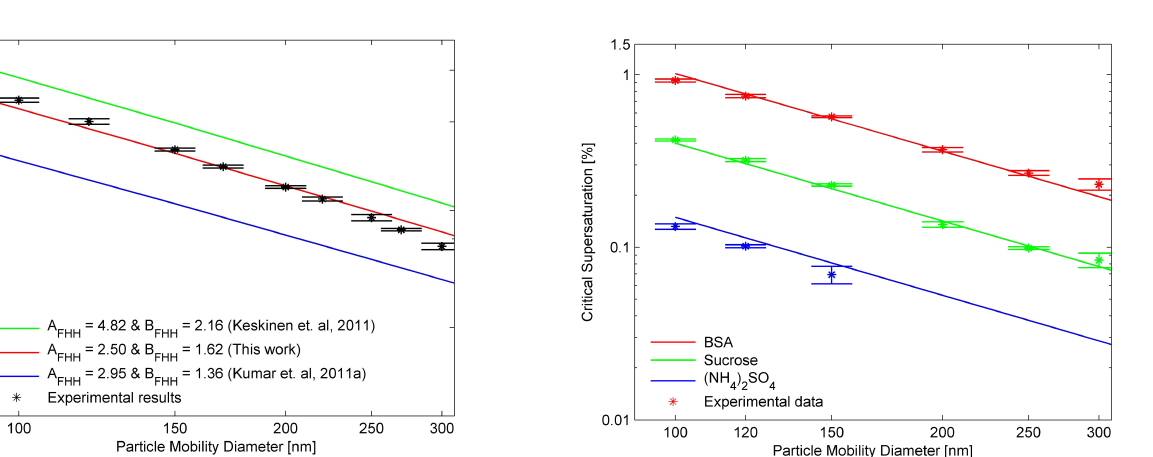
Figure 7. Experimental and theoretical critical supersaturations of pure (NH 4 ) 2 SO 4 , sucrose and BSA particles for different mobil- ity diameters based on κ -Köhler theory. Error bars represent the minimum vs. maximum values of supersaturation to estimate the s c corresponding to each d b